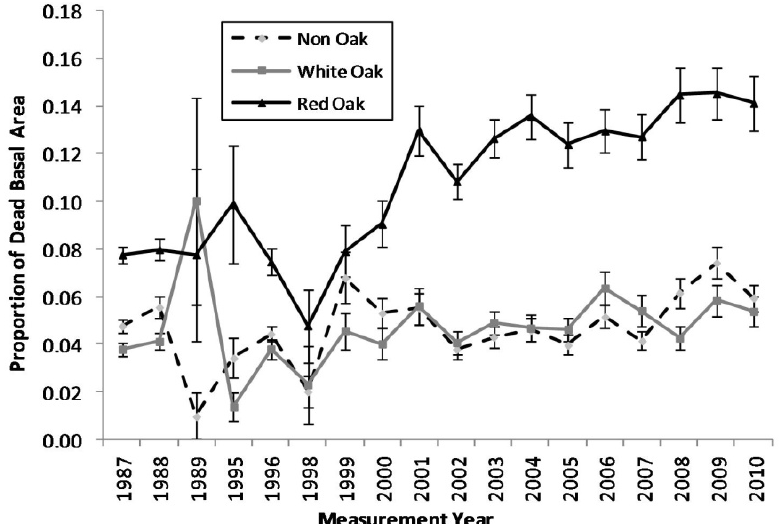
Figure 1. Proportion of dead basal area for each measurement year for red oak, white oak, and non oak species (The vertical bars represent the standard error of dead basal area for each species